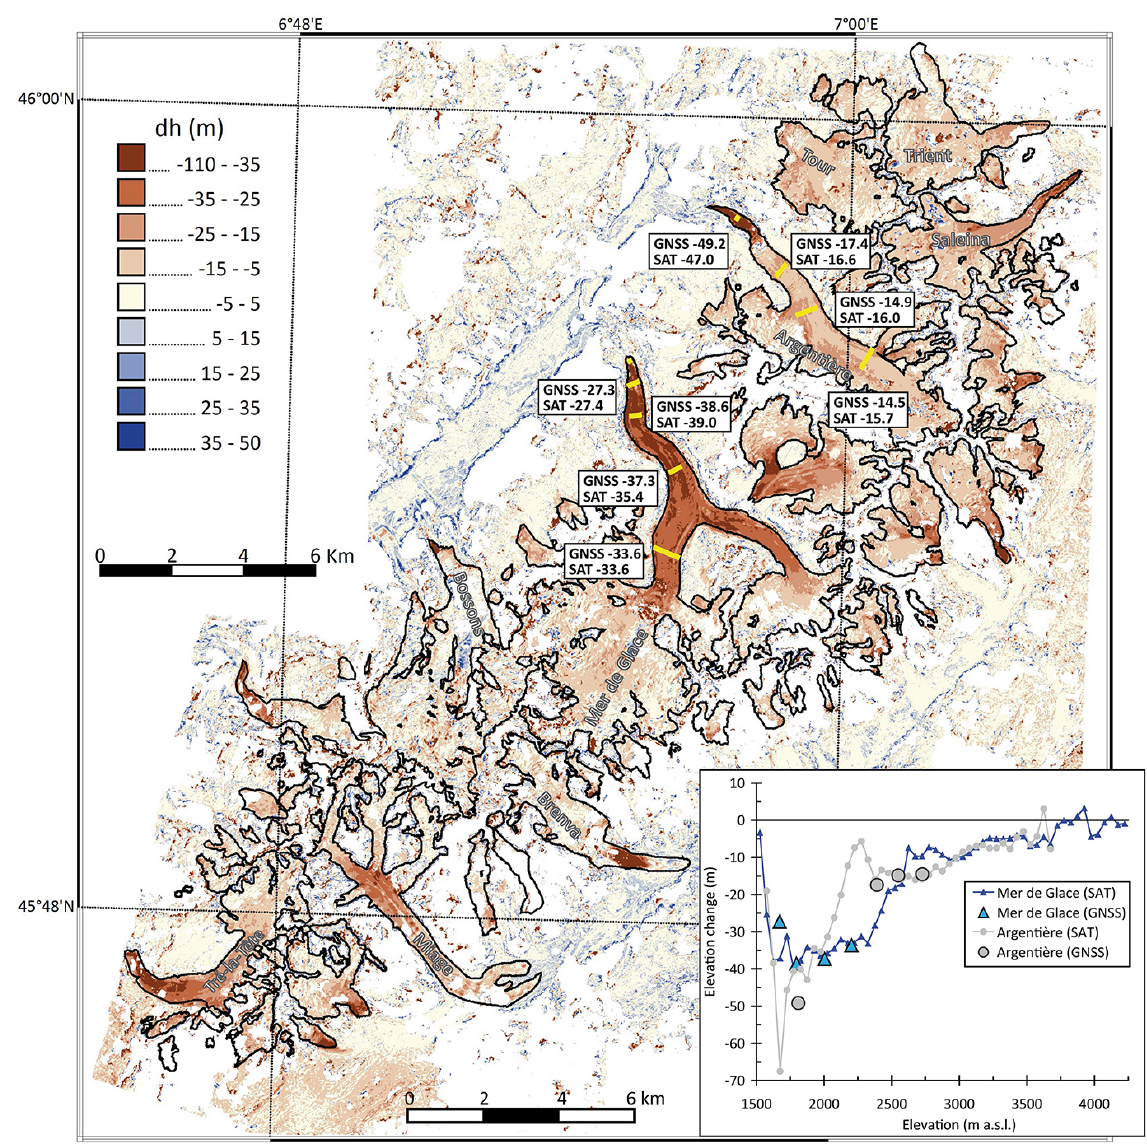
Figure 8. Elevation differences between the SPOT 5 DEM from 19 to 23 August 2003 and Pléiades DEM from 19 August 2012 over the Mont-Blanc area. In yellow, the location of the transverse profiles where elevations are measured every year using differential GNSS. The field (noted GNSS) and satellite (SAT) 2003–2012 elevation differences averaged along these profiles are indicated. Inset: satellite-derived (SAT, small symbols) and field (GNSS, large symbols) elevation changes as a function of altitude for the Mer de Glace (blue) and the Argentière (grey) glaciers. Large symbols correspond to the field